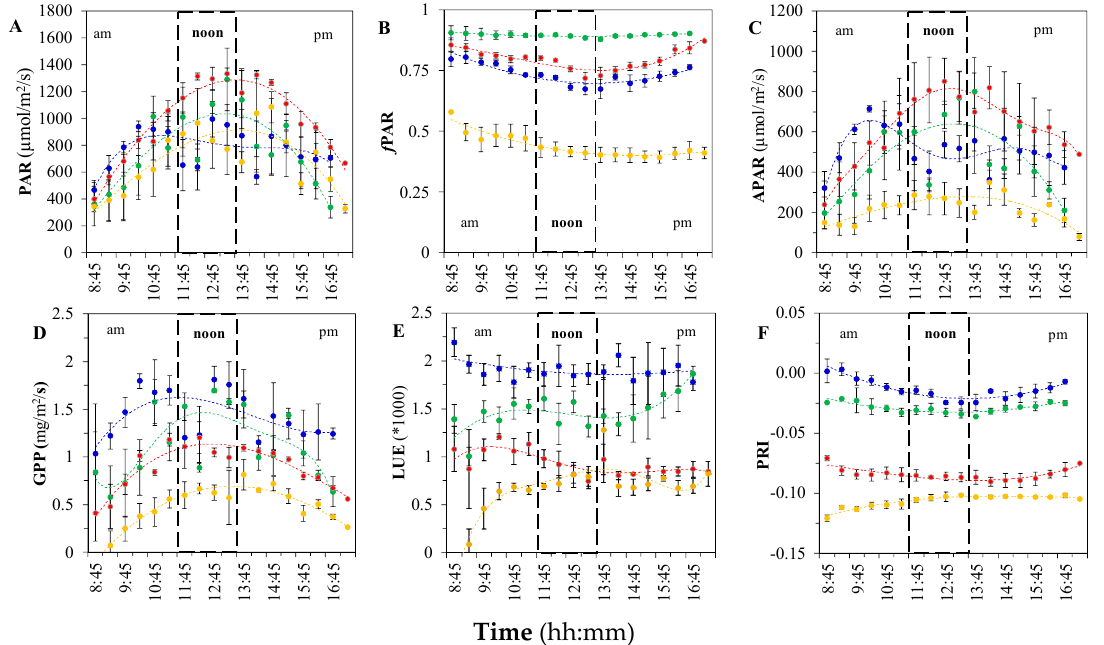
Figure 4. Diurnal and seasonal variations in photosynthetically active radiation (PAR, µmol/m 2 /s), absorbed PAR (APAR), fraction of APAR ( f APAR), gross primary production (GPP), light use efficiency (LUE), and photochemical reflectance index (PRI). Each value represents a mean (±SE of the mean, n = 12) of the measurements collected at this time on three consecutive clear days, representative of key growth sages for corn. The growth stages are indicated in different colors (blue—young, green—mature, red—early senescence, yellow—late senescence).